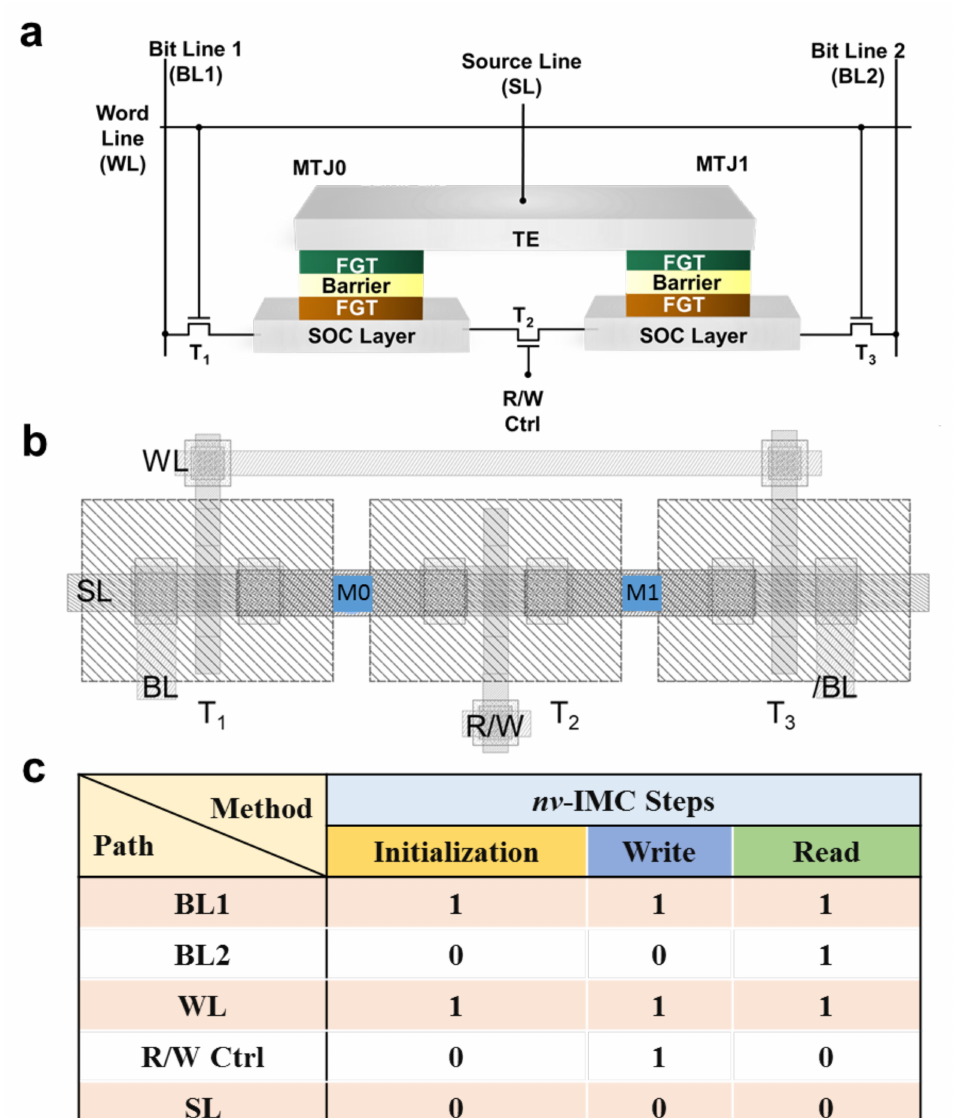
Figure 3. The storage cell structure and corresponding operation scheme. ( a ) 3T2M memory cell structure diagram. ( b ) The layout of 3T2M structure. ( c ) 3T2M memory cell initialization,